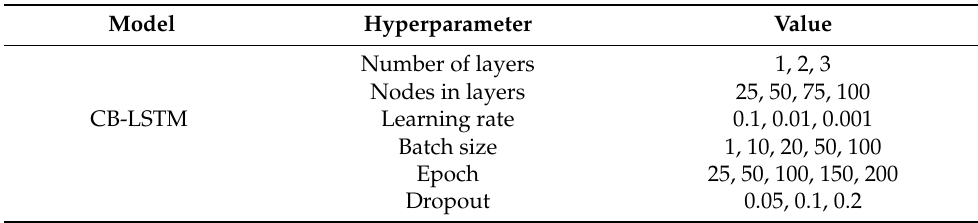
Table 4. Hyperparameters to